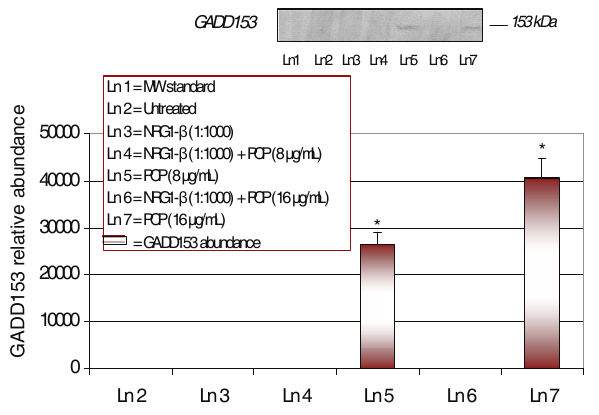
Figure 5: Expression and relative abundance of the 153 kDa GADD in AML 12 mouse hepatocytes exposed to PCP and NRG1- β + PCP for 48 h. AML 12 mouse hepatocytes were treated with 8 µg/mL and 16 µg/mL concomitant treatments of PCP and NRG1- β + PCP. GADD153 protein identification was assessed following exposure incubation period of 48 h. representative Western blot analysis. Each point represents a mean value and standard deviation of three experiments. *Significantly different ( p < 0.05 ) from untreated (0 µg/mL PCP) and NRG1- β (1:1000) treated cells.